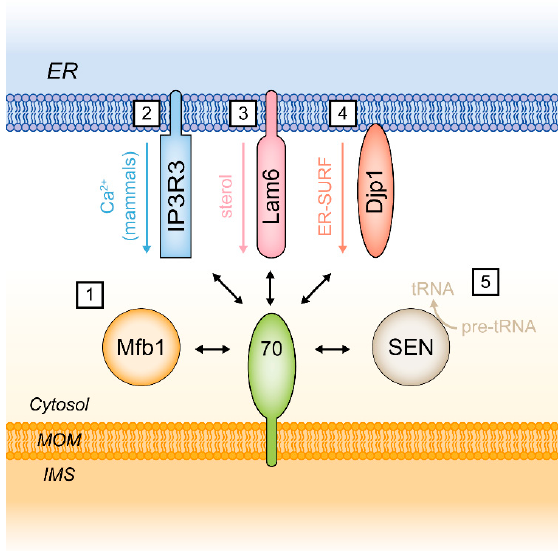
Figure 6. Functions of Tom70 as a molecular tether. (1) Tom70/71 recruits Mfb1 to the mitochondrial